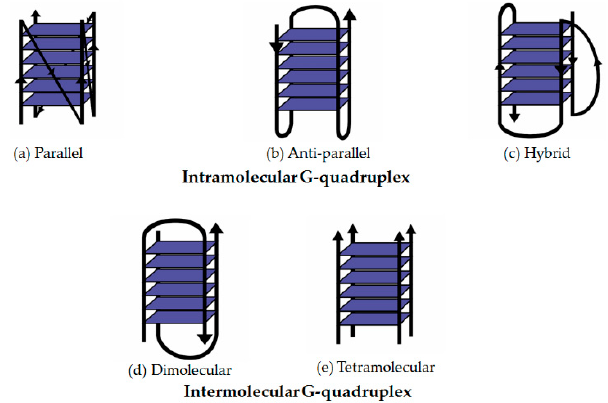
Figure 4. Common conformations of G-quadruplex. ( a ) Parallel ( b ) Anti-parallel ( c ) Hybrid ( d ) Anti-parallel (dimolecular) ( e ) Parallel (tetramolecular).